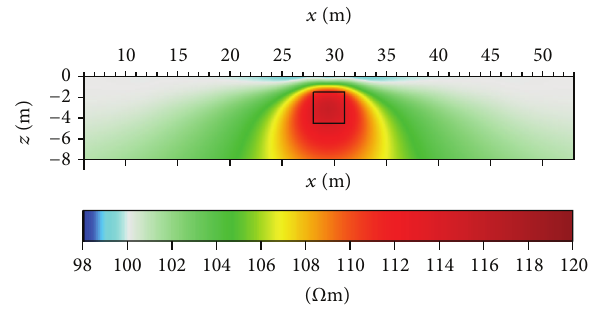
Figure 1: Back-projection obtained using transposed matrix B T , simulating a 2D model with a resistive square body (1000 Ω m) buried in a homogeneous medium (100 Ω m).